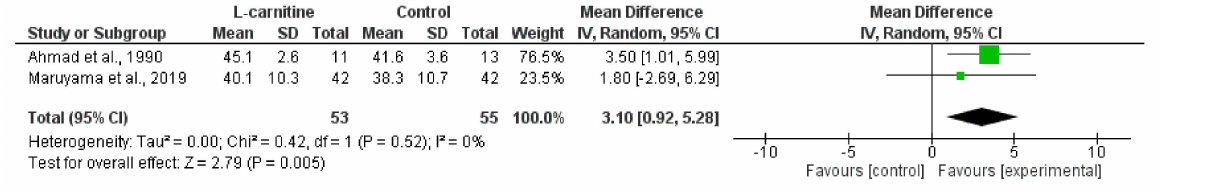
Figure 7. Effect of L-carnitine supplementation on mid-arm muscle area in individuals receiving haemodialysis. Data are expressed as mean difference and 95% CI [18,43].